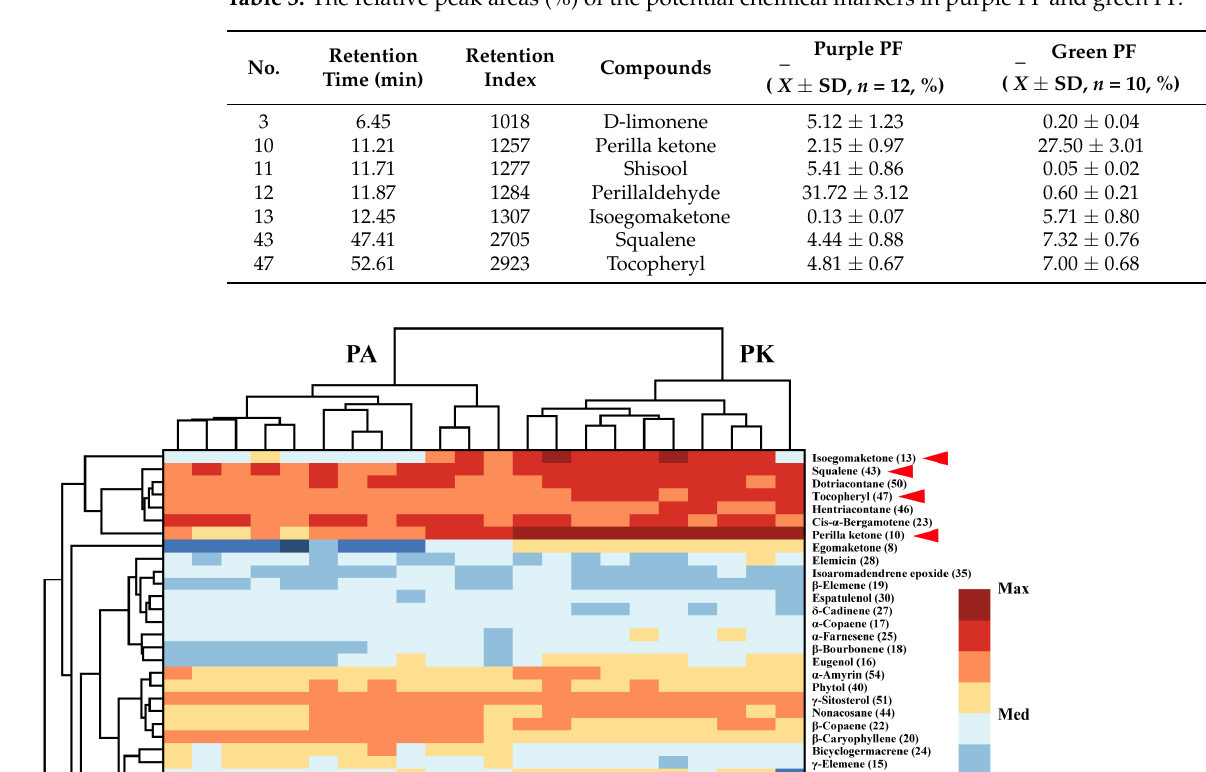
Table 3. The relative peak areas (%) of the potential chemical markers in purple PF and green PF.